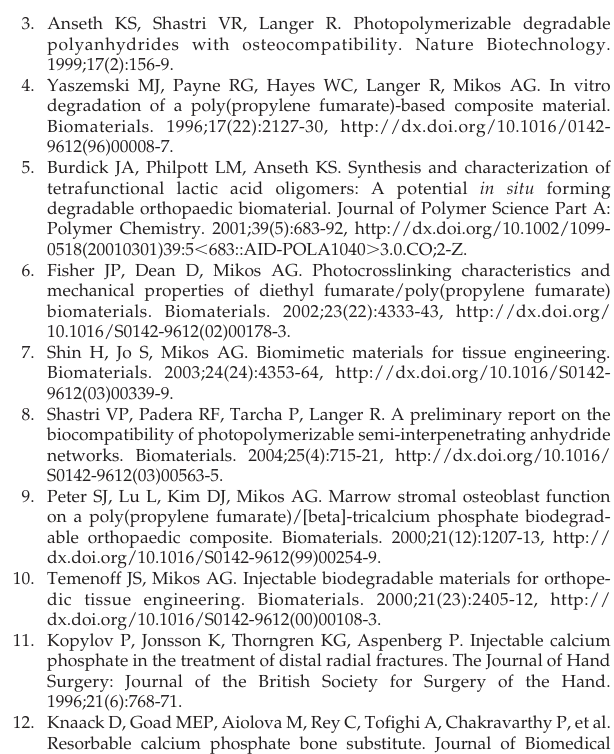
Figure 6 - Percentage of DNA (A), GAG (B) and collagen (C) after seeding, with 95%